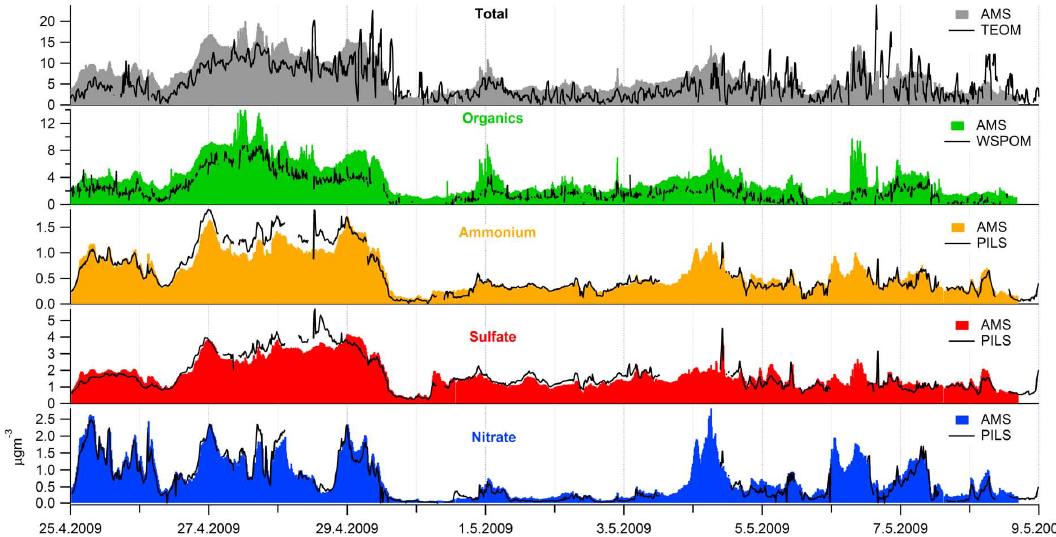
Fig. 2. Concentrations of major ions and WSPOM (using conversion factor 1.6 to convert WSOC to WSPOM) measured by PILS-TOC-IC and AMS from 25 April to 8 May 2009. PILS-TOC-IC (ions, WSPOM) and TEOM (total mass) results are marked with the black line. AMS results are marked with colors (blue=nitrate, red=sulfate, yellow=ammonium, green=total organics, grey=total mass i.e. sum of ions and